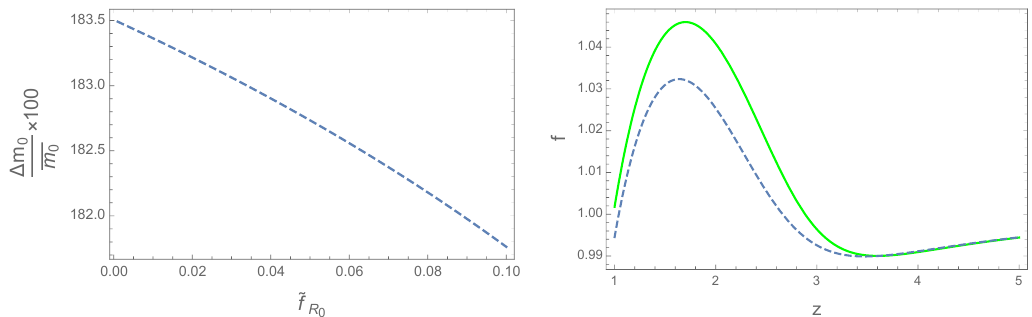
Figure 3 . The percentage deviation for m 0 between the models (3.5) and (3.52) for initial values in the interval 0 . 001 ≤ ˜ f R ≤ 0 . 1 and η = 4 . For ˜ f R < 10 − 3 the percentage deviation tends to settle 0 0 around ∼ 183 . 5% . This difference in the initial value of m ( m varies in the range 10 − 2 to 10 − 4 along this interval) is reflected in the behavior of the growth rate of matter perturbations as shown in the right curve for the mode k = 600 a 0 H 0 and ˜ f R = 10 − 2 , where the green line corresponds to 0 the model (3.5) and the dashed line to the model (3.52). The curves differ in the maximum f and in the transition redshift. The results have been obtained from the exact formulas for m